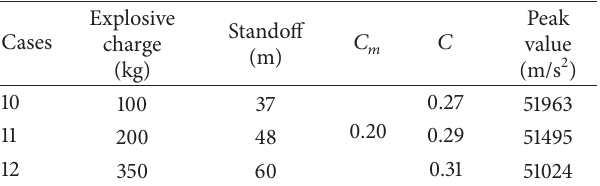
Table 4: Acceleration peak values of spherical shells in different